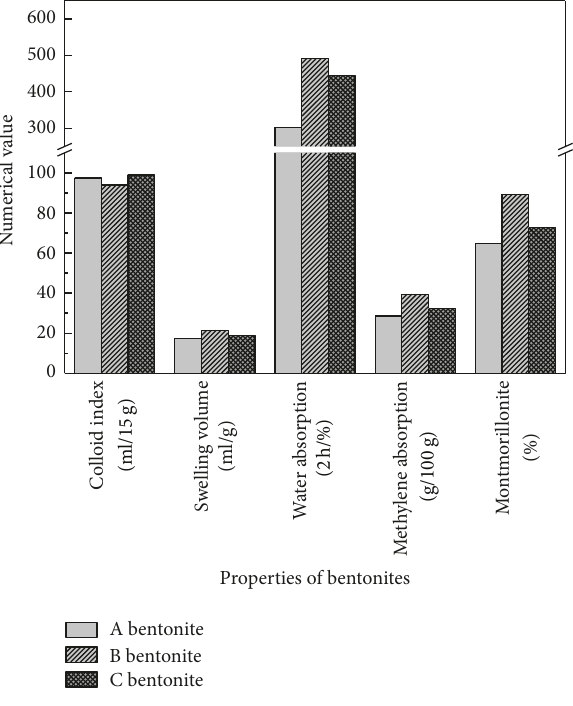
Figure 4: Results of bentonite pellet